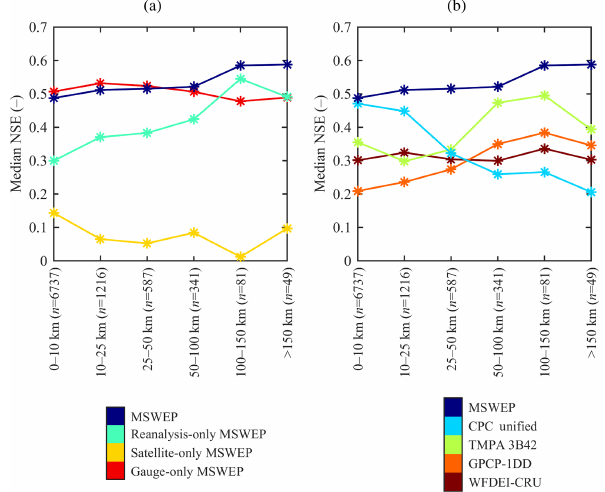
Figure 9. The change in median calibration NSE for the P datasets as a function of catchment-mean distance to the closest P gauge. The distance to the closest P gauge was computed using the GPCC and CPC Unified datasets. The NSE scores have been computed between simulated and observed Q time